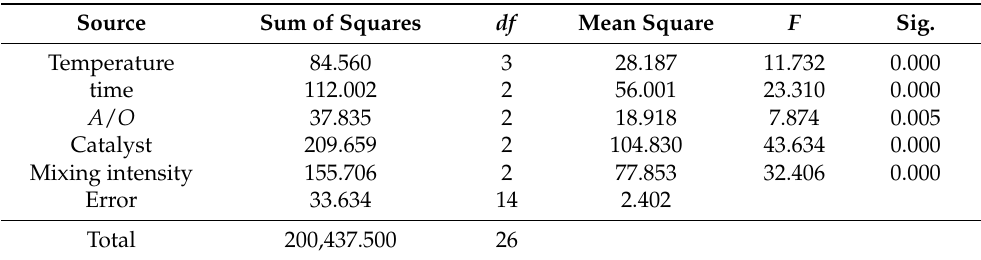
Table 3. Tests of between-subjects effects (dependent variable: BPY et). df : degree of freedom. R 2 = 0.933 (adjusted R 2 = 0.880).